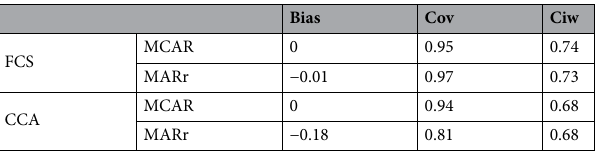
Table 1. Bias of the estimates ( E ( Y )), coverage of nominal 95% confidence intervals (Cov) and the corresponding confidence intervals widths (Ciw) under MCAR and MARr.